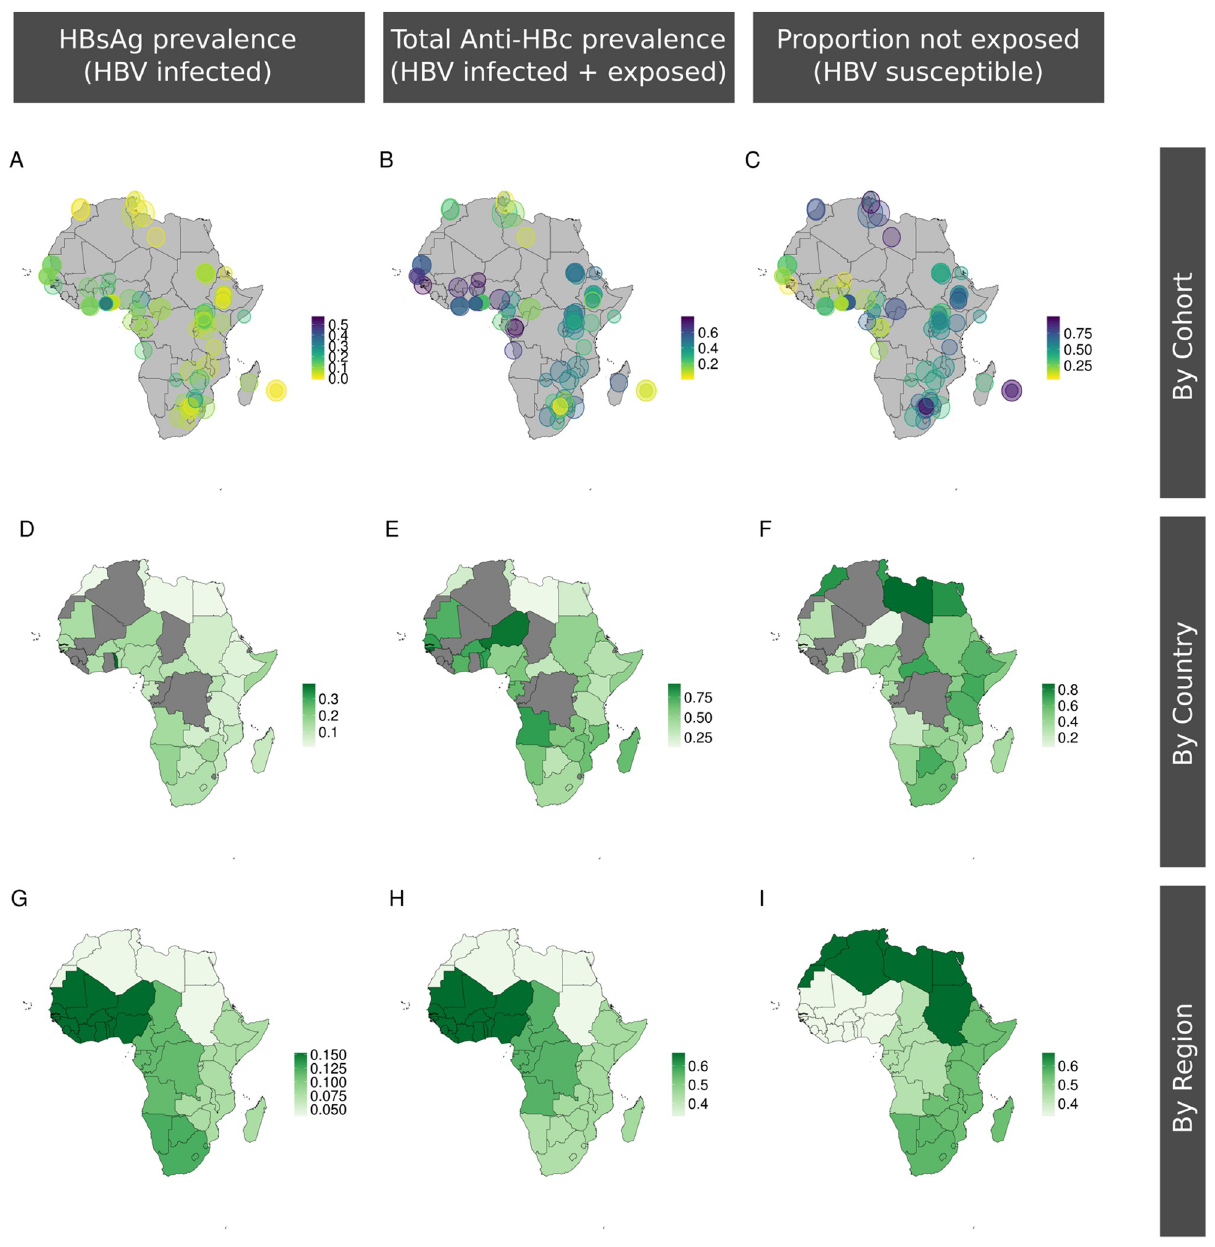
Fig 3. Maps demonstrating the location and HBV seroepidemiology of adult cohorts identified through a systematic literature review. First row shows data by individual cohort, depicting (A) HBsAg prevalence, (B) anti-HBc prevalence (exposed plus infected), and (C) HBV susceptible population (100% of population minus anti-HBc prevalence). Each circle is placed to represent the location of the cohort. Second row shows data by country (D–F) and third row by region (G–I). Each area is coloured to reflect high to low prevalence of the attribute in question (scale bar as shown on each panel). Countries shown in grey have no data. The cohort metadata are available online at Figshare: 10.6084/m9.figshare.6154598, and an interactive version of these maps can be accessed online [29]. Outline maps available as open source from http://www.maplibrary.org/library/index. htm. Anti-HBc, antibody to hepatitis B core antigen; HBsAg, hepatitis B surface antigen; HBV, hepatitis B virus.